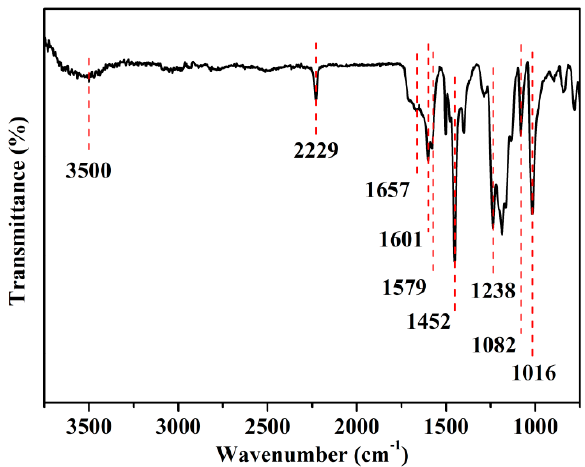
Figure 1. FTIR spectra of SCPEN copolymers.